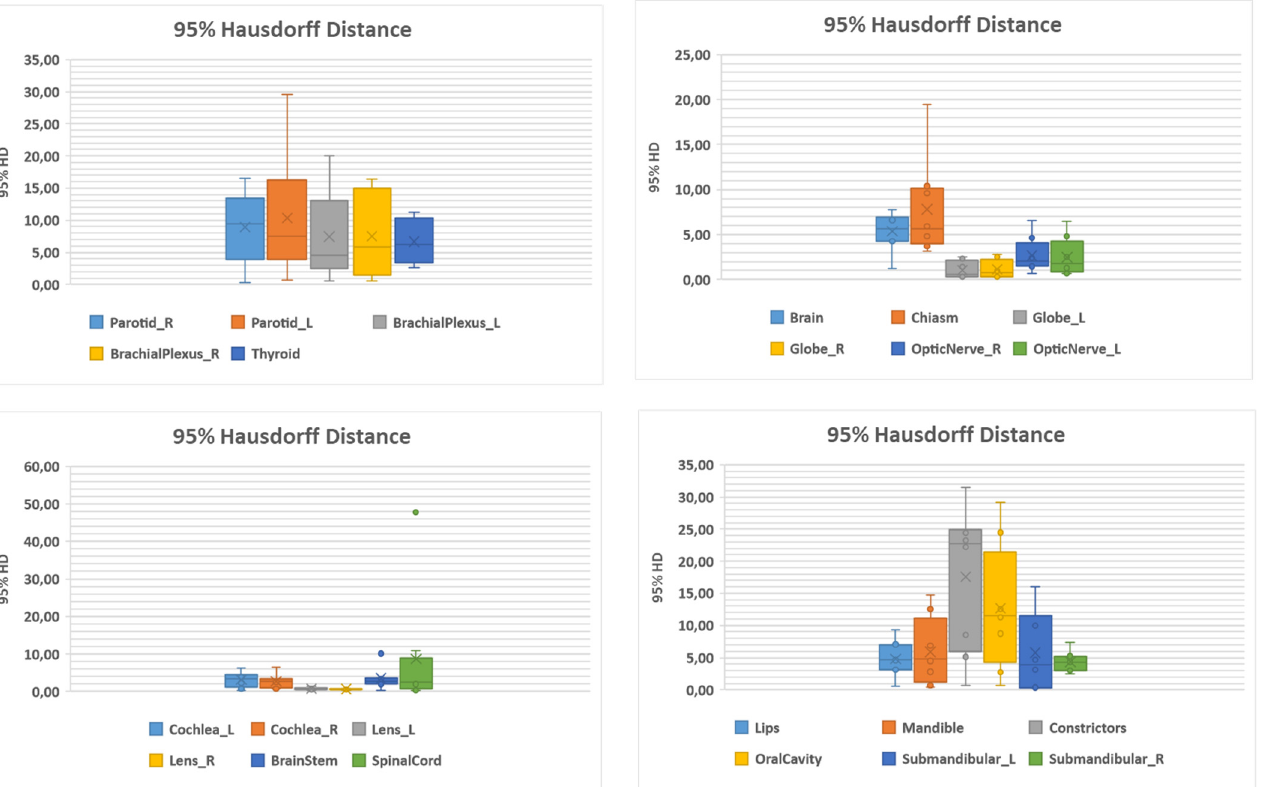
Figure 2. Boxplot analysis of 95% Hausdorff distance.